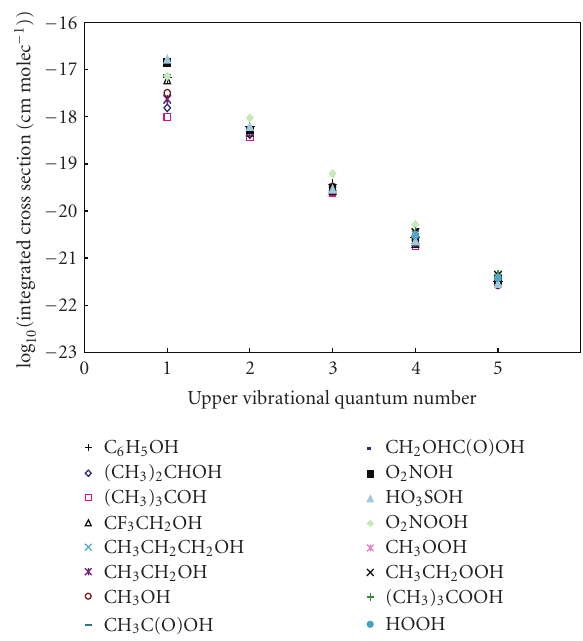
Figure 2: Compilation of theoretical O–H stretching integrated